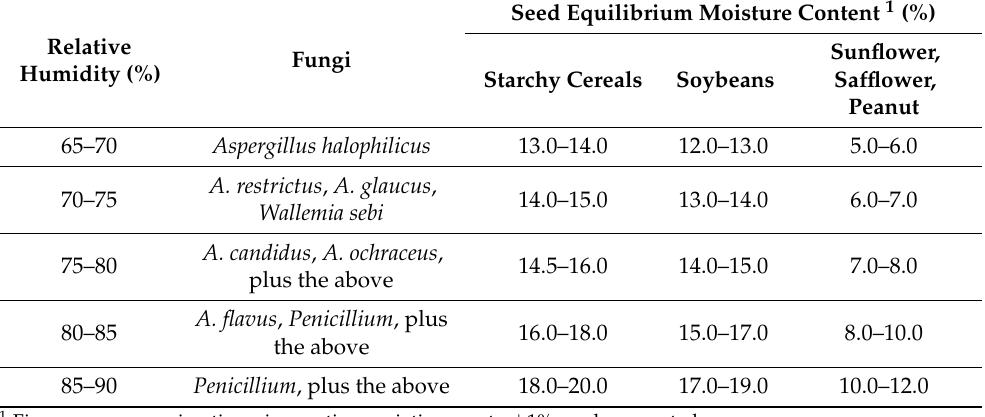
Table 1. Minimum relative humidity and seed moisture content for the growth of common storage fungi (from Meronuk